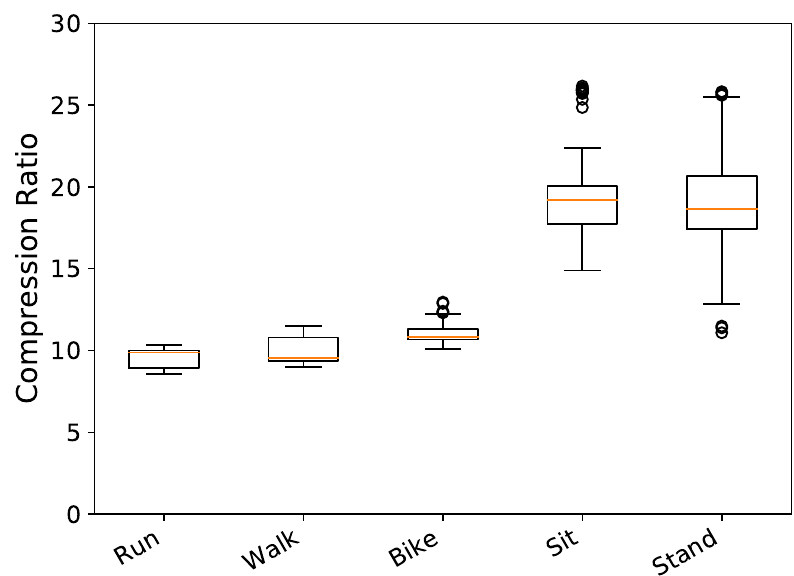
Figure 3. Distribution of compression ratio (original size/compressed size) of each movement activity using delta encoding. Stationary movement activities experience greater compression than active movement